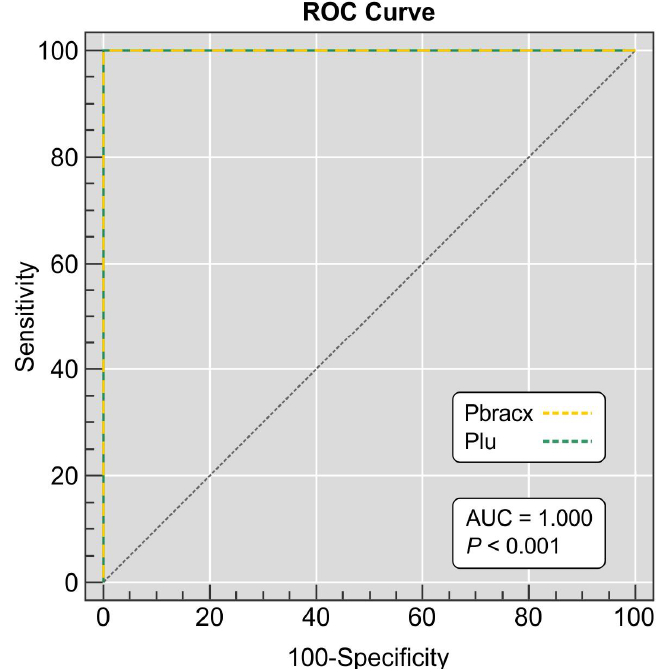
Figure 3. Receiver operating characteristics (ROCs) depicting duplex PCR assay sensitivity and specificity. Samples were from 49 P. brasiliensis complex isolates, 13 P. lutzii isolates, and 68 non-target fungal DNA derived from agents of superficial, subcutaneous, and systemic mycoses in humans and animals. The ROC is plotted between the true-positive rate (sensitivity) on the y -axis and the false-positive rate (100-specificity) on the x -axis. The area under the curve (AUC) represents the accuracy of the duplex assay, which was 1.000 (95% CI 0.972–1.000, p < 0.0001).